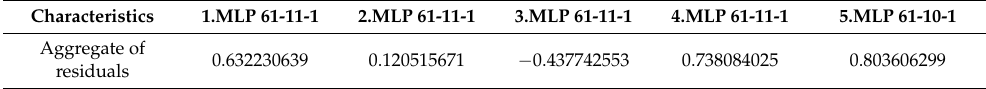
Table 7. Aggregate of the residuals for the individual equalized time series.